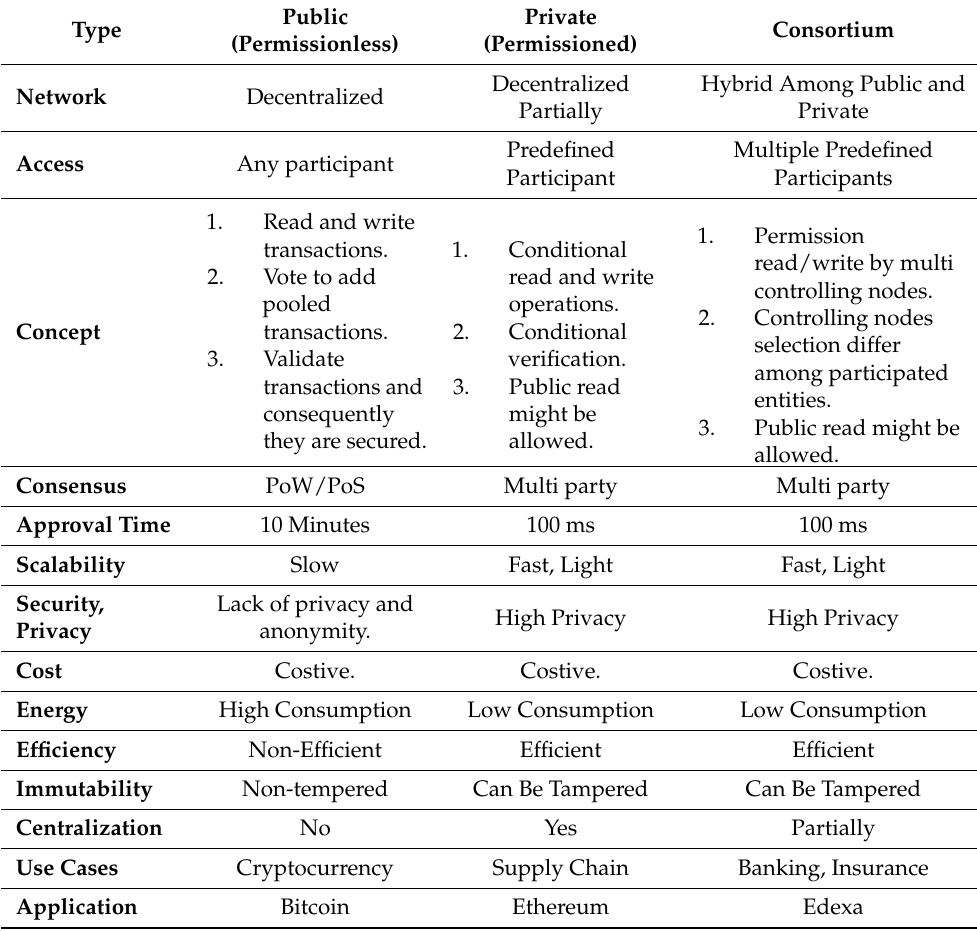
Table 1. Blockchain